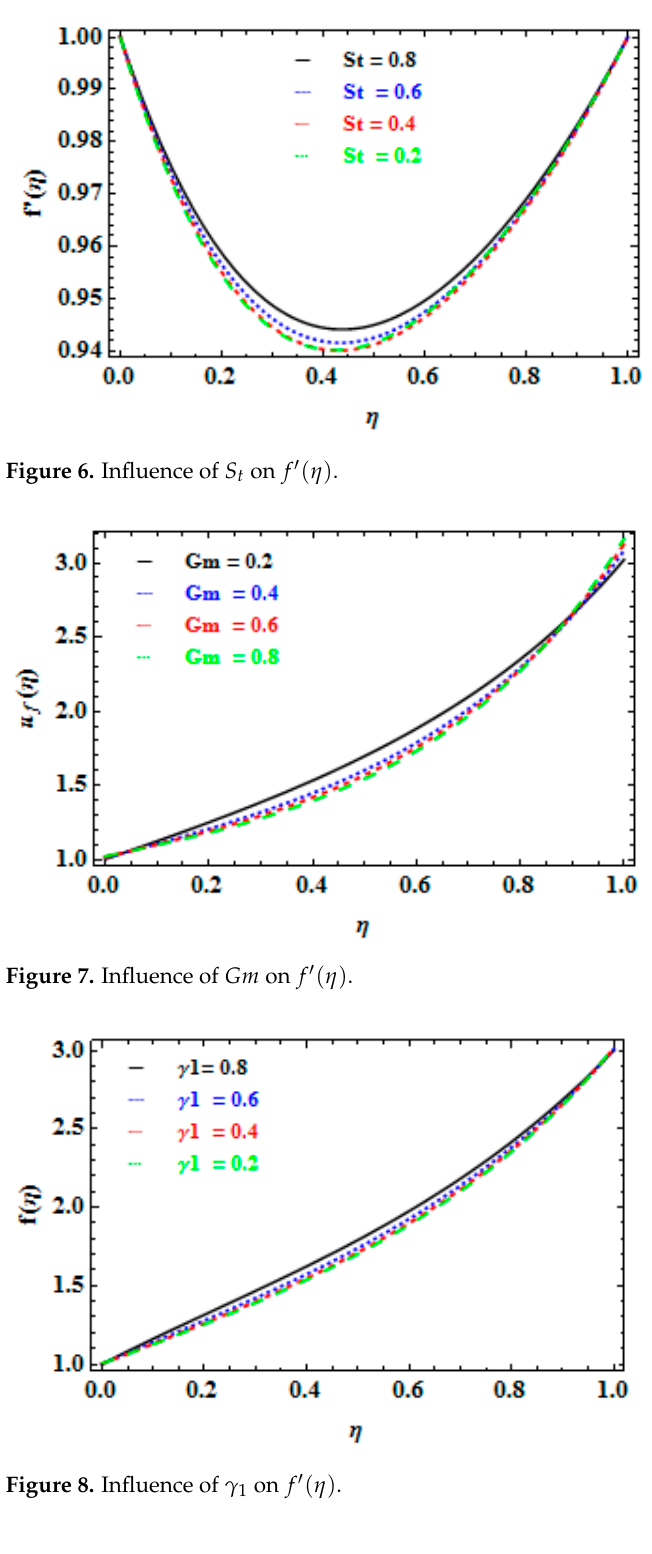
Figure 9. Influence of G r on 𝑓 (cid:4593) ( 𝜂 ) . Figure 10. Influence of M